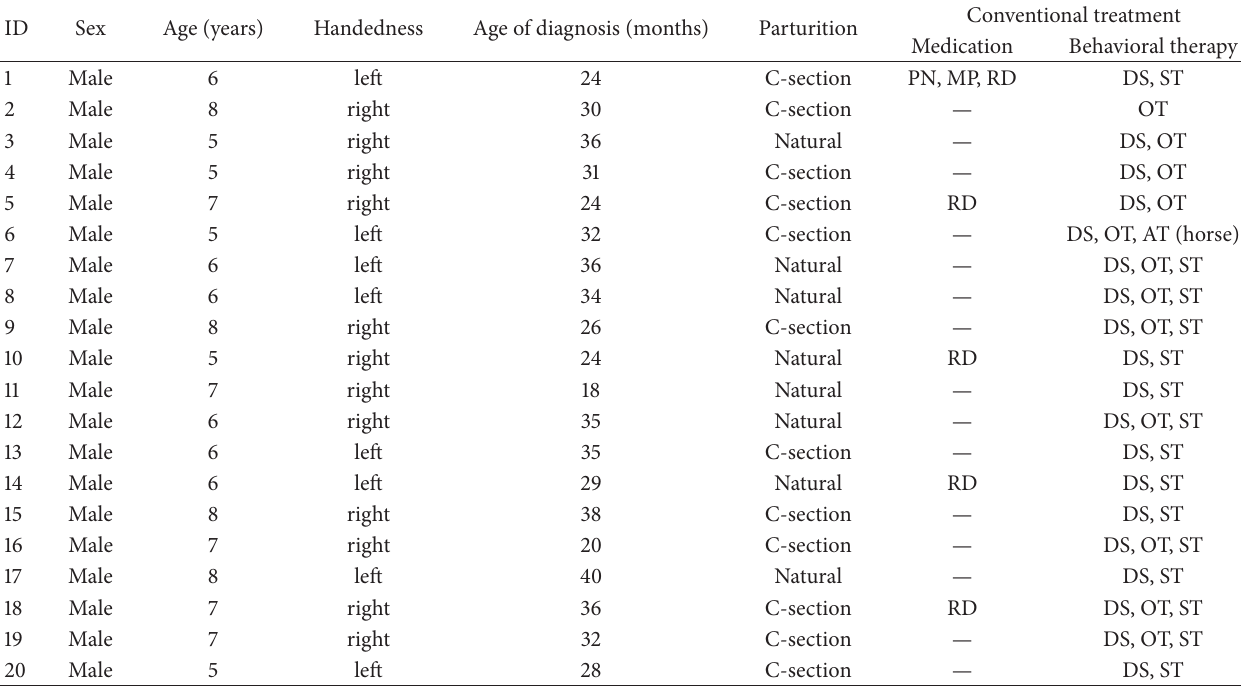
Table 1: Descriptive data for the study participants ( 𝑛 = 20 ).